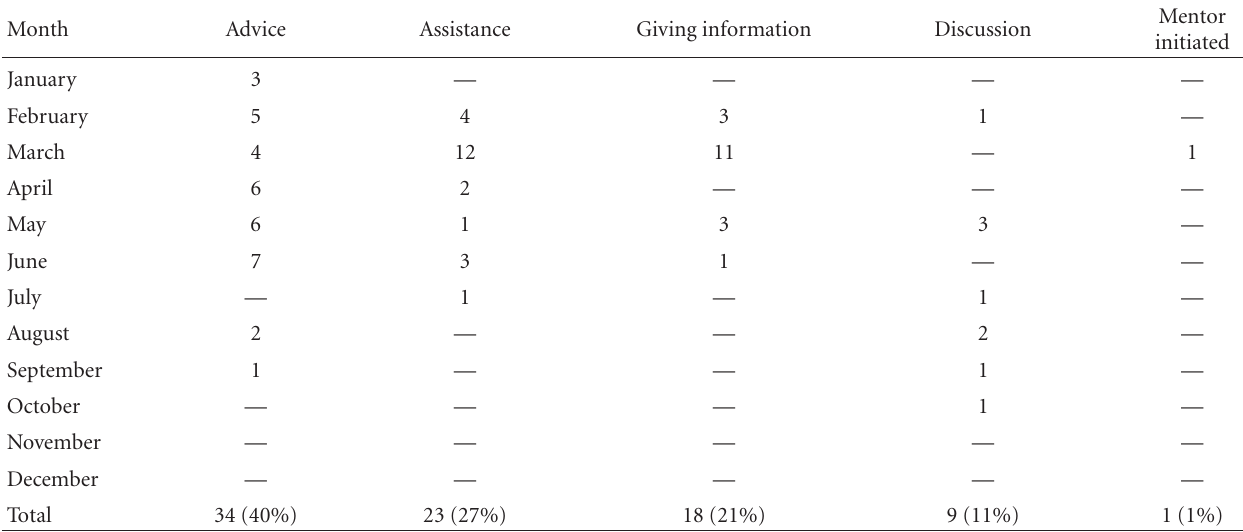
Table 1: Reasons new graduates contacted mentors over the